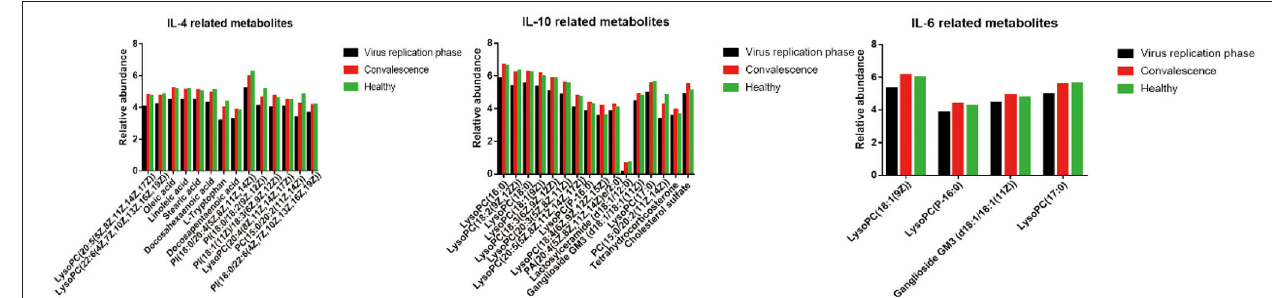
FIGURE 5 | Change of expression level metabolites related to the cytokines.